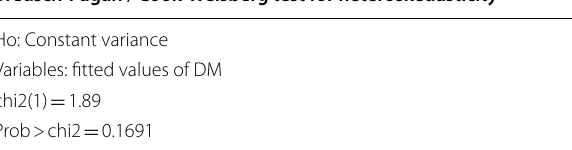
Table 6 Fixed effect model for identifying determinants of